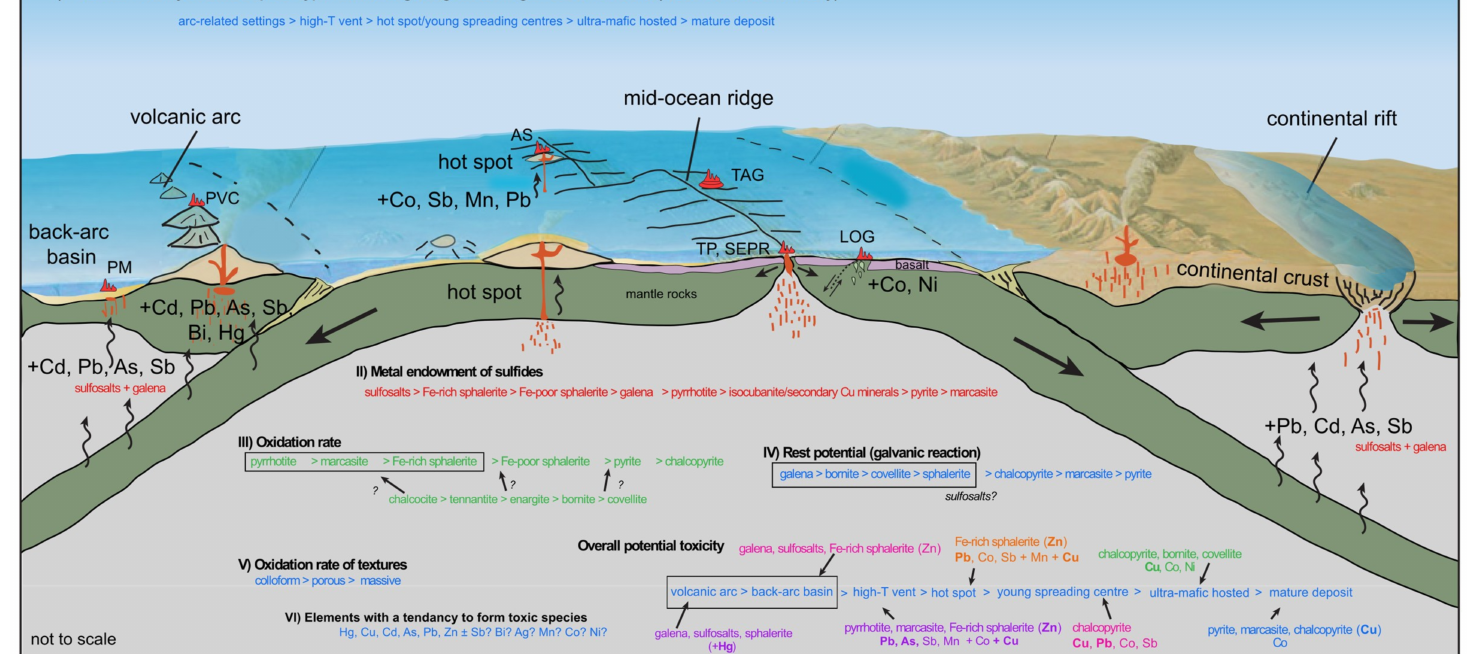
Figure 12. Visual representation of the variables that effect potential toxicity with assessments of inferred toxicity versus seafloor massive sulfides (SMS) ore deposit type (with schematic of geological settings) and mineralogy derived from the analyses performed in this study. (I) Potential toxicity based on bulk chemistry of different deposit types, (II) metal endowment (potentially toxic content) of sulfide minerals, (III) oxidation rate of each sulfide mineral, (IV) rest potential (galvanic reaction potential) of each sulfide mineral, (V) oxidation rate of mineral textures and (VI) elements with a tendency to form toxic species. The overall potential toxicity of deposit types (tectonic settings) is stated based on all variables to demonstrate the variation and highlight particular minerals and elements of concern for each. It is important to note that this is potential toxicity, and no recommendations of mining targets can be made without further quantitative toxicity data. Also shown are the potentially toxic trace elements commonly associated with each tectonic